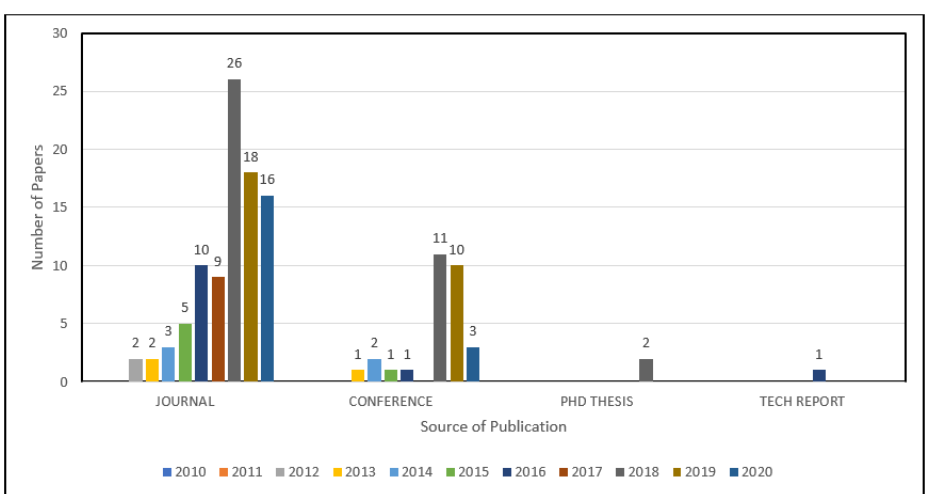
Figure 2. Distribution of Papers According to Type of